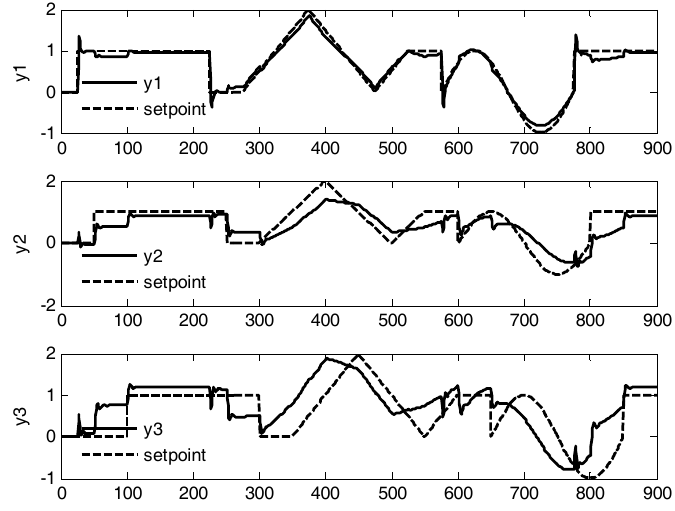
Figure 12. Control results for one controller broken.